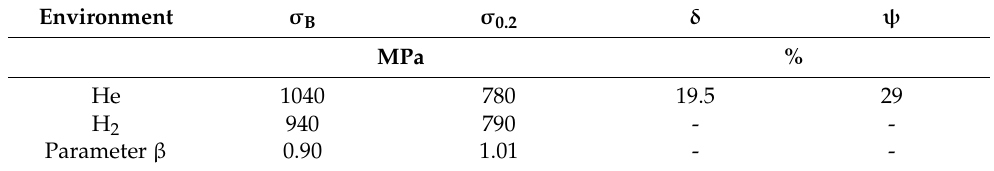
Table 4. Tensile tests results for SLM Inconel 718 in hydrogen and helium at 80 MPa.